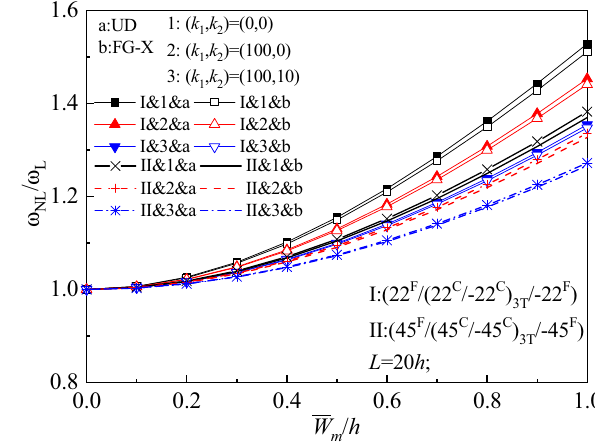
Figure 10: E ff ect of foundation coe ffi cient on nonlinear vibration for hybrid plates.